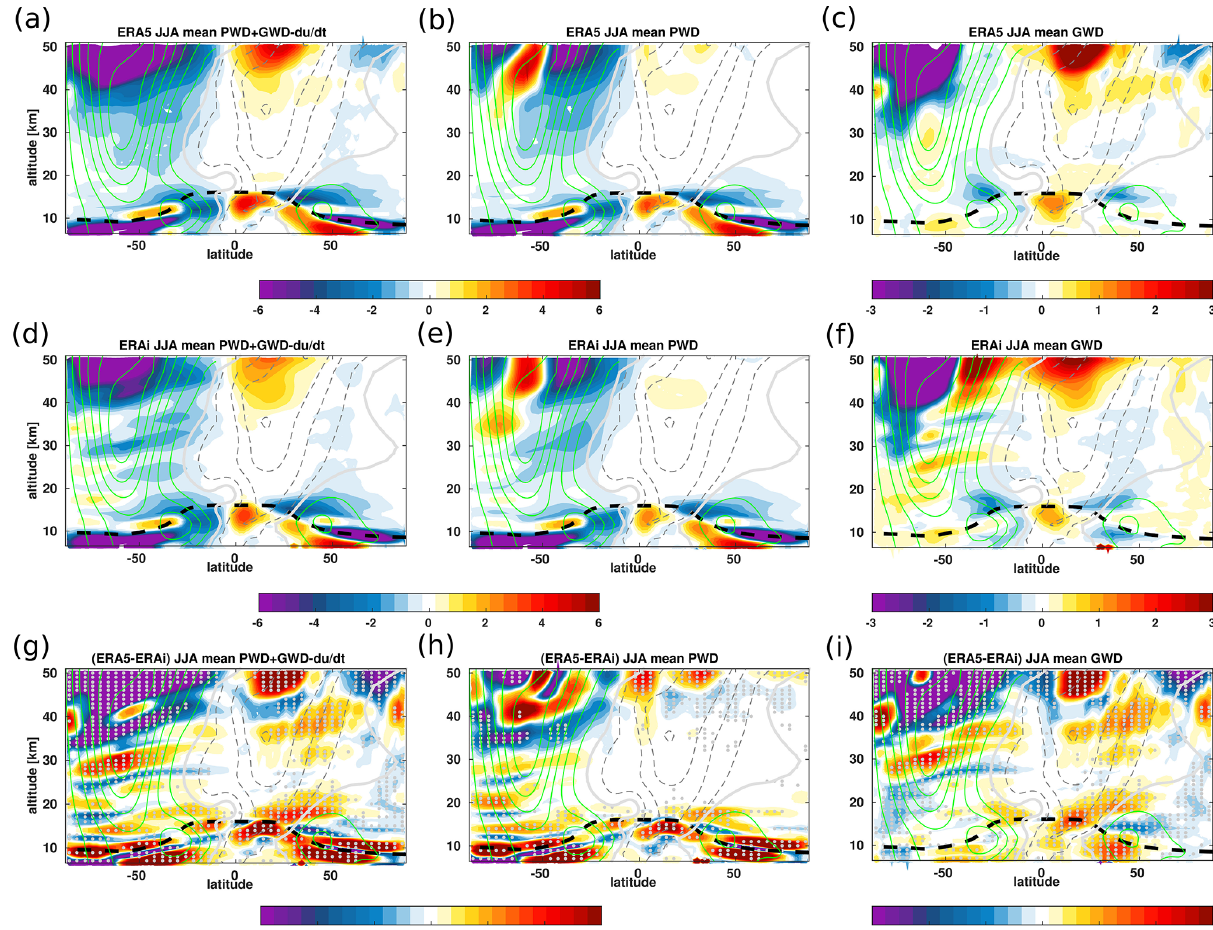
Figure A2. Zonal mean distribution of the summer seasonal mean (JJA) net wave forcing (a, d) , planetary wave drag (b, e) , and gravity wave drag (c, f) , together with the associated differences (g–i) between the ERA5 (a–c) and ERA-Interim (d–f) reanalyses for the 1979–2018 time period. The unit of the wave drag is in ms − 1 d − 1 . Grey dots in panels (g–i) indicate regions where the differences between the ERA5 and ERA-Interim reanalyses are statistically significant at 95% estimated using Student’s t test. The climatological tropopause from the ERA-Interim is indicated as the dashed black horizontal line. The thick white line indicates the zero-line zonal mean wind. The thin green and grey lines indicate the climatological zonal mean